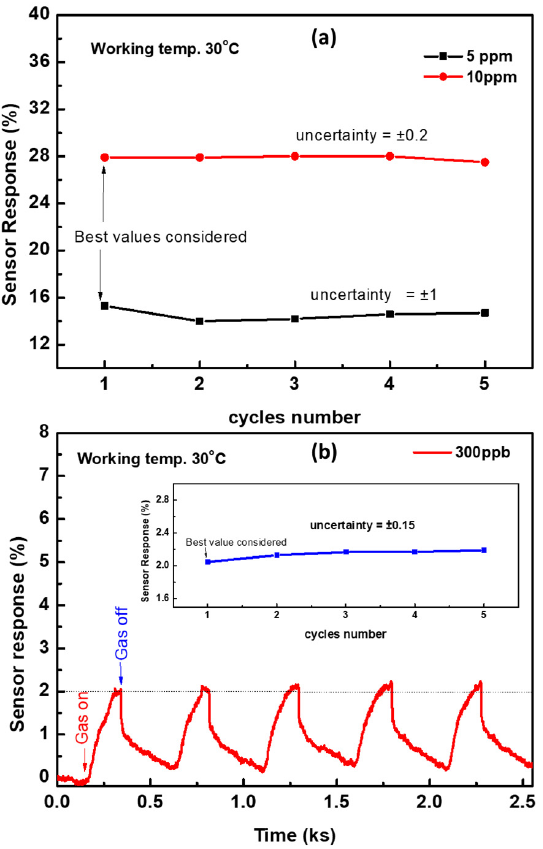
Figure 11. ( a ) The sensor response as a function of cycles number for a concentration of 5 and 10 ppm calculated from the device signal measured at 30 ◦ C. ( b ) Cyclic sensor response for a gas concentration of 300 ppb at 30 ◦ C, and the inset shows the sensor response as a function of cycle number. The error percentages for concentrations of 300 ppb, 5 ppm, and 10 ppm are 7.5%, 6.5%, and 0.7%, respectively.